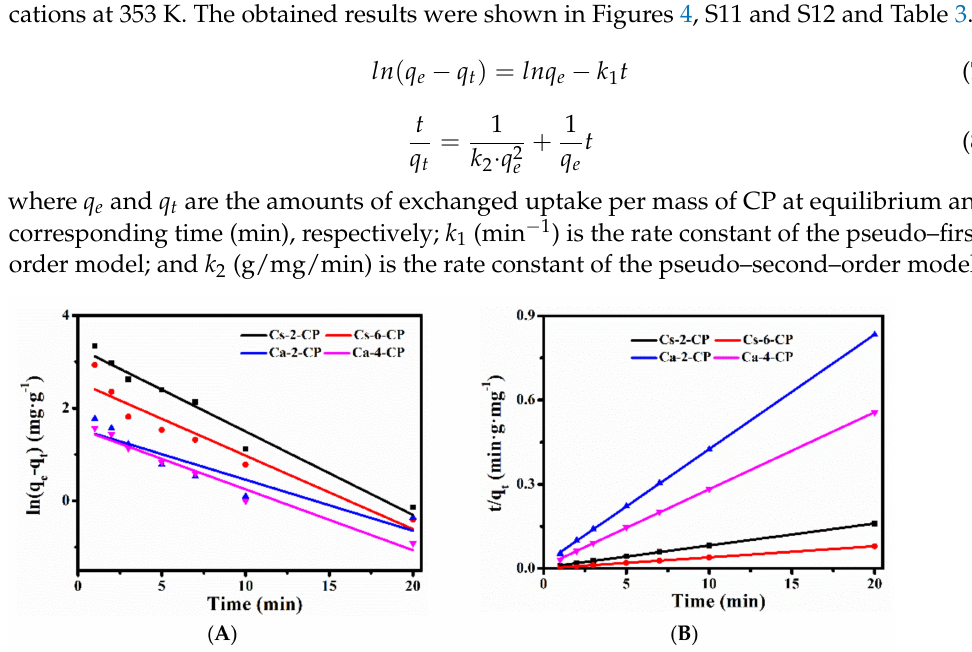
Figure 4. Pseudo-first-order model ( A ) and Pseudo-second-order model ( B ) fitted for Cs–x–CP and Ca–x–CP at 353